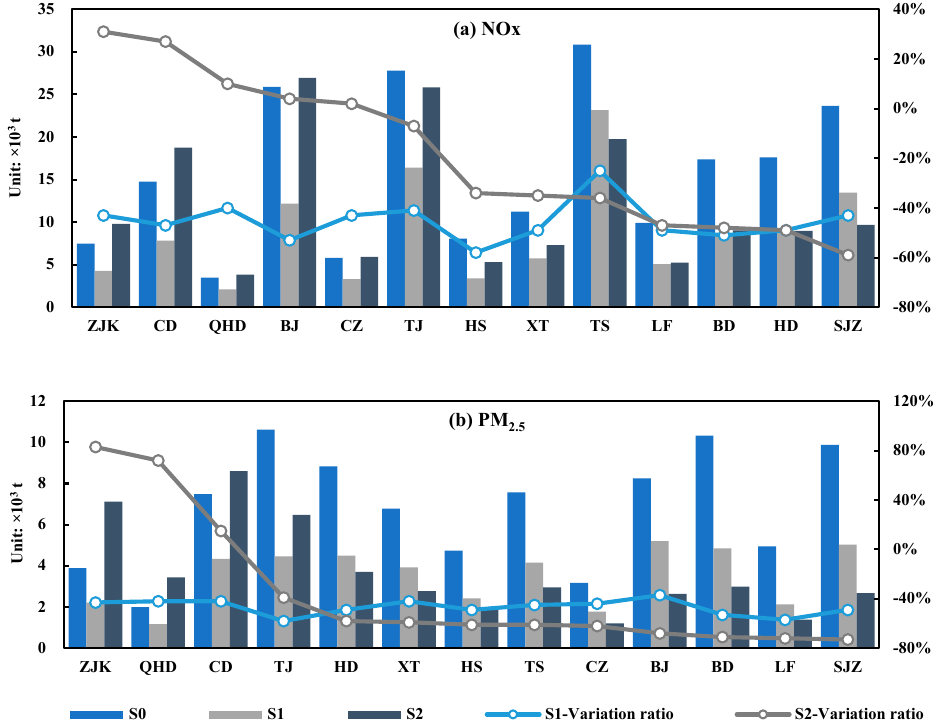
Figure 4. Emissions of two pollutants (NOx and PM 2.5 ) under different emission scenarios .